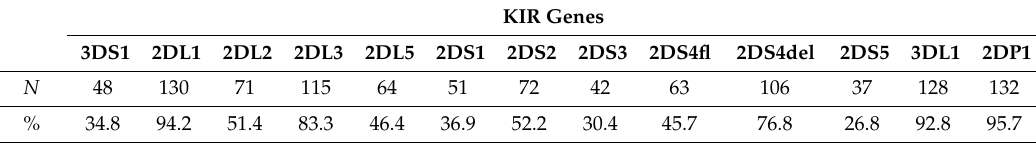
Table 2. Frequency of each KIR gene in 138